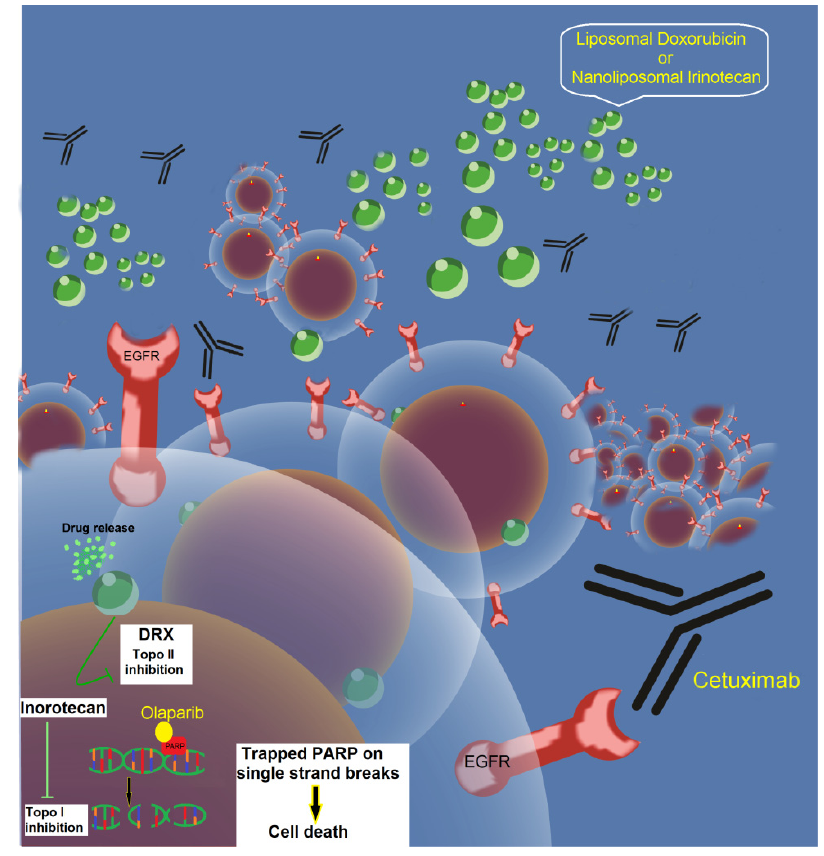
Figure 2. Combination therapy proposal.